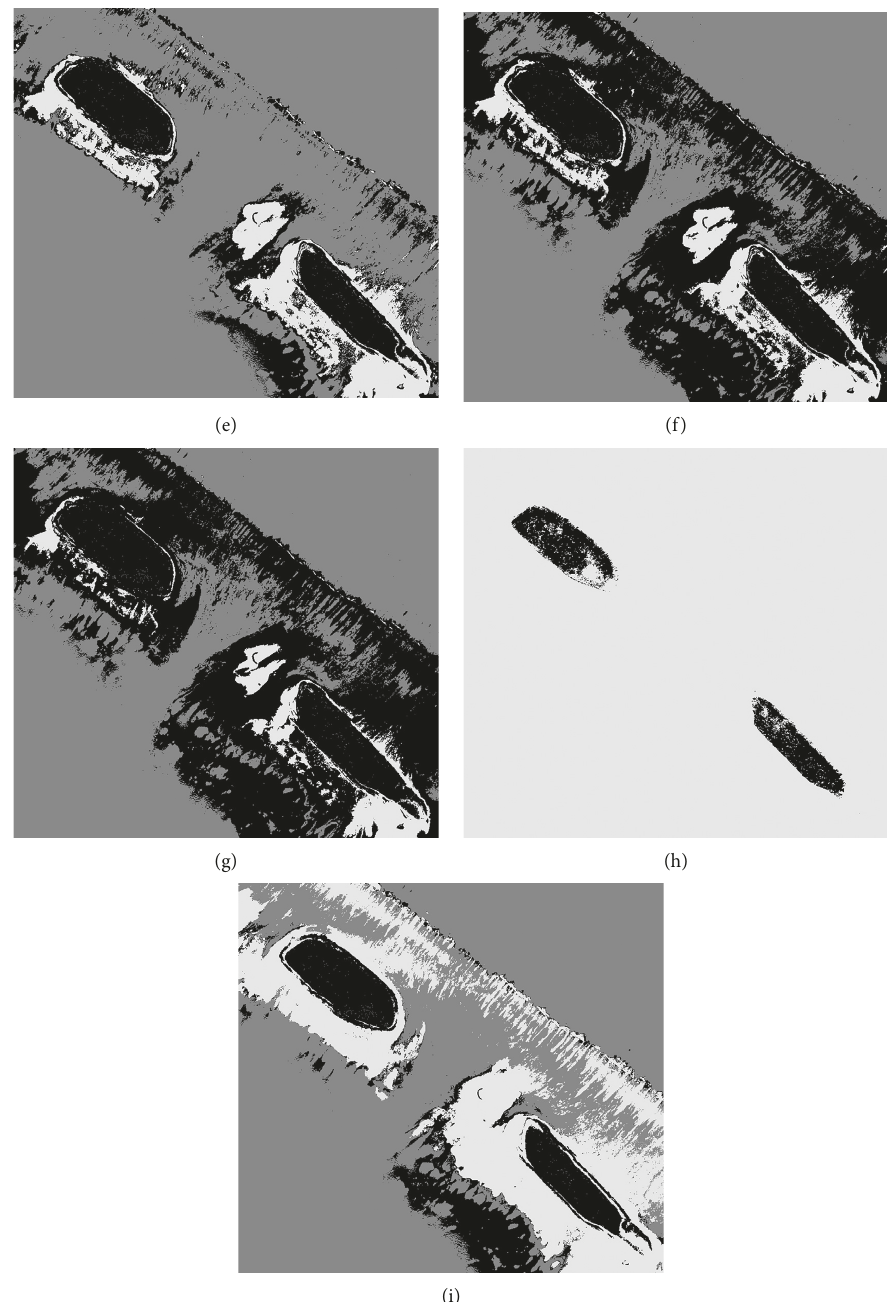
Figure 4: The classification processing results of GLDFS in conventional bands and characteristic bands and GLCM in principal component data: (a) blue band, (b) green band, (c) red band, (d) near-infrared 1 band, (e) coastal band, (f) yellow band, (g) infrared band, (h) near- infrared 2 band, and (i) principal component